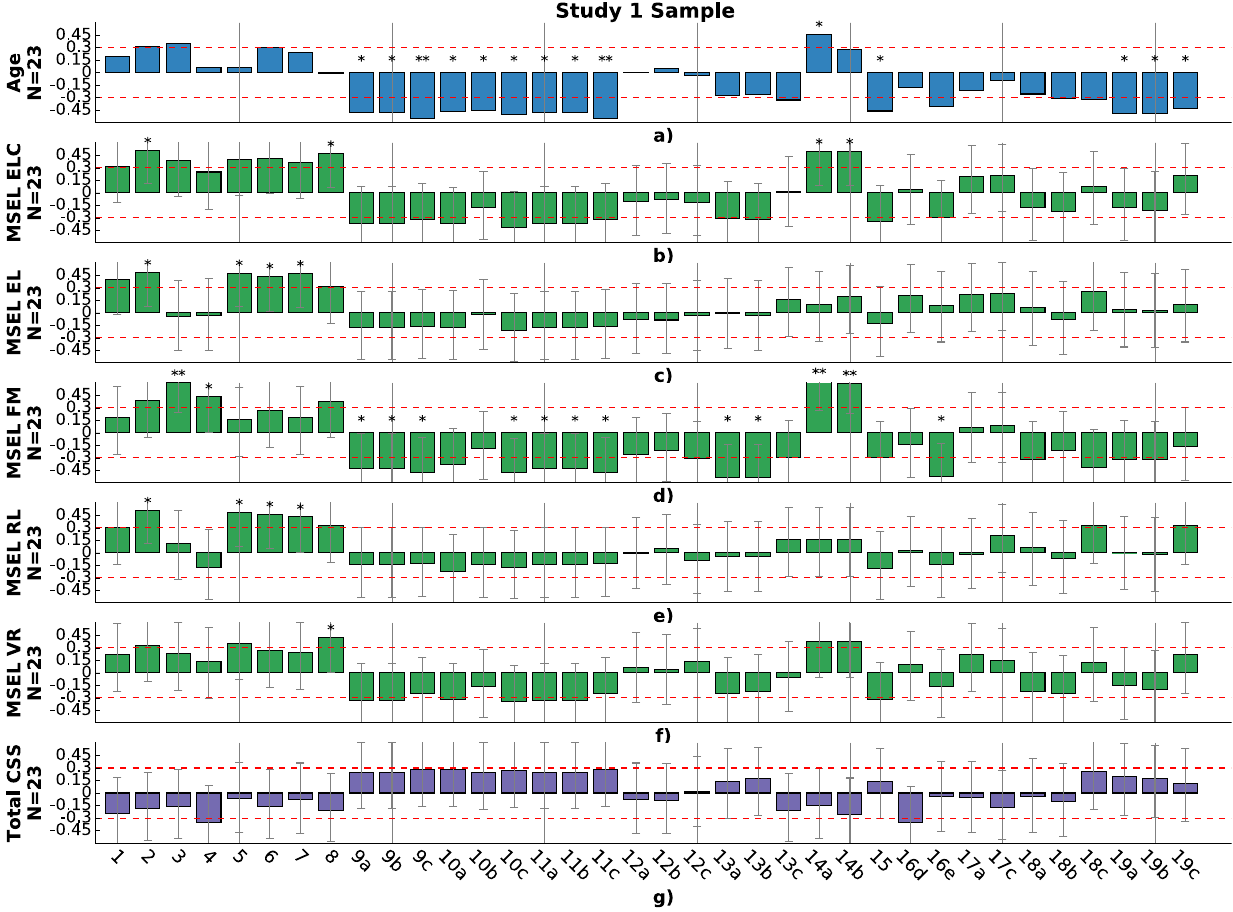
Fig. 5 Correlations between computed motor-related variables (columns) and clinical measures (rows) for the study 1 sample. The height of the bar indicates the value of the partial correlation between a speci fi c game variable and a clinical measure. (1) number of touches ; (2) number of pops ; (3) bubble popping rate; (4) double touch rate ; (5) screen exploratory percentage ; (6) number of targeted ; (7) number of transitions ; (8) repeat percentage ; (9) touch duration ; (10) touch length of the touch motion ; (11) touch velocity ; (12) applied force ; (13) distance to the center ; (14) popping accuracy; (15) average variation of the popping accuracy; (16d) variability of the average popping accuracy ; (16e) variability of the maximum popping accuracy ; (17) number of touches per target ; (18) touch frequency ; (19) time spent on a targeted bubble . a Mean; b Median; c Standard deviation; * p < 0.05; ** p < 0.01; *** p < 0.001. P -values were computed using a Student ’ s t-test. Red dotted line indicates level of correlation of .3 and -.3. MSEL Mullen Scales of Early Learning, ELC Early Learning Composite Score, EL Expressive Language T-Score, FM Fine Motor T-Score, VR Visual Reception T-Score, ADOS-2 Autism Diagnostic Observation Schedule – Second